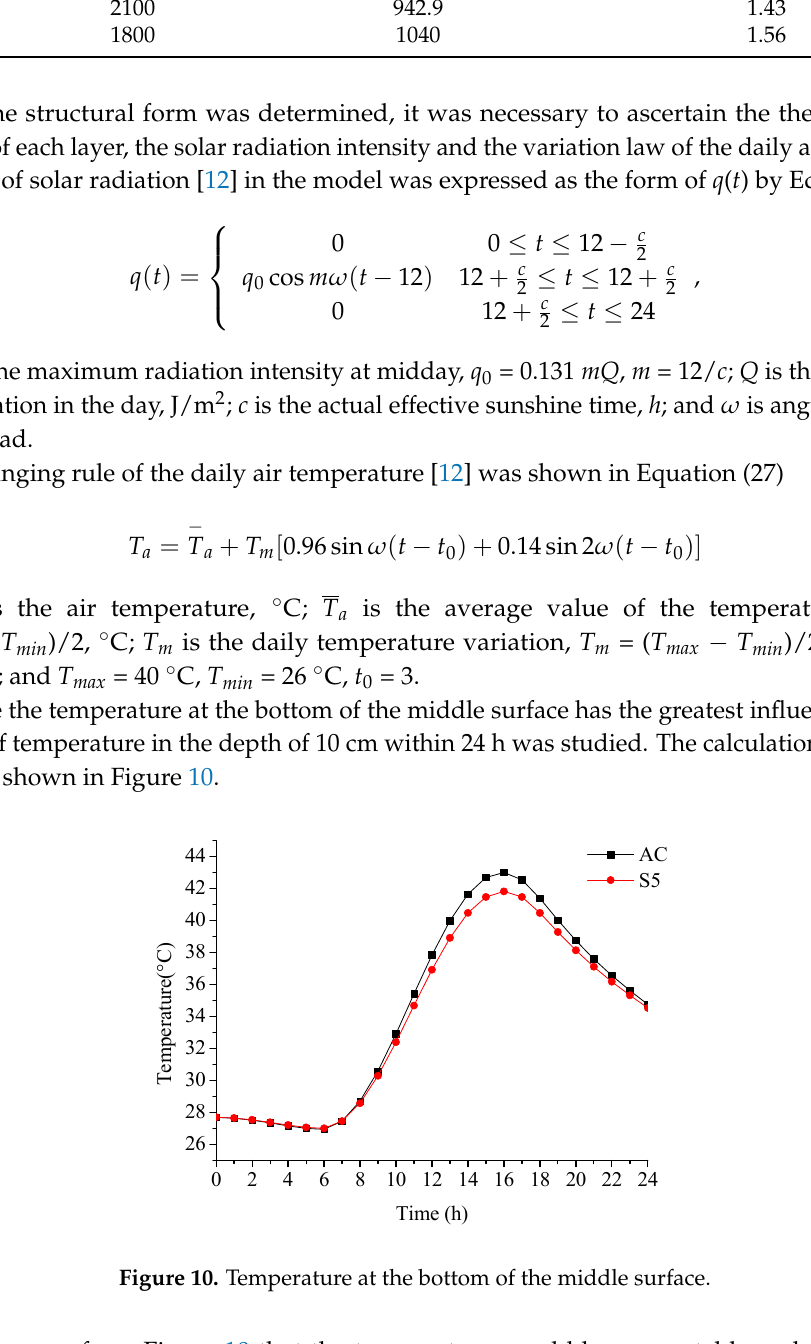
Table 12. Thermally physical properties of each layer.